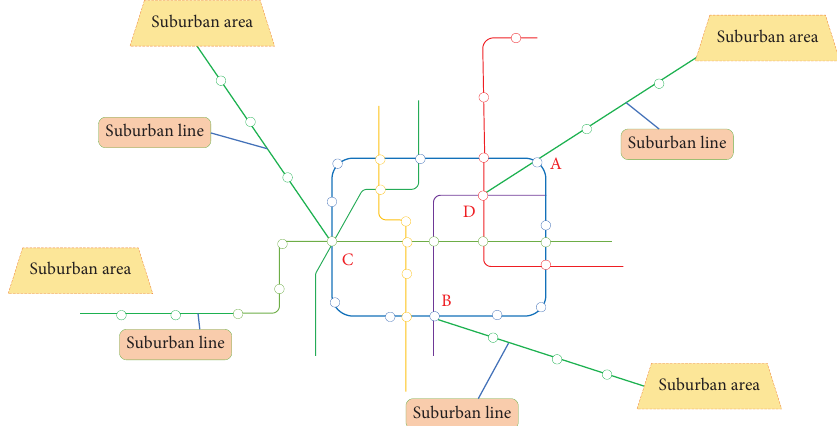
Figure 1: Schematic diagram of the urban backbone network and suburban line structure.